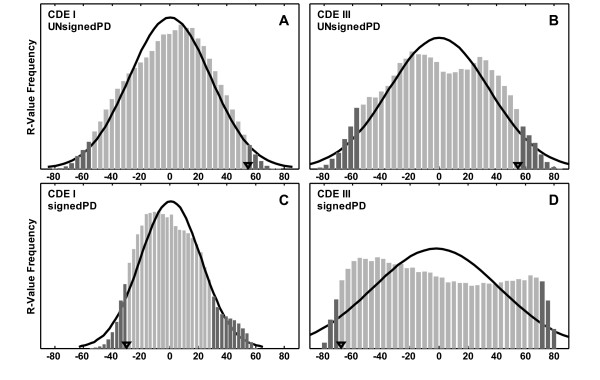
Histograms of Monte Carlo R-value distributions for CDEI & CDEIII sites as a result of randomizing the PD-scale. Histograms of the Monte Carlo distributions of R values are shown calculated from 105 randomizations of PD-scale values. In each histogram the actual value from the true PD-scale is marked by a triangle along the x-axis. Shaded dual tail areas correspond to probabilities of better correlations than the actual value reported in Table 1. The normal curve, superimposed on each of the histograms using the mean and standard deviation of the distribution, reveals the normal character of the CDEI distributions (A) & (C) and contrasts with the bimodal CDEIII distributions (B) & (D).